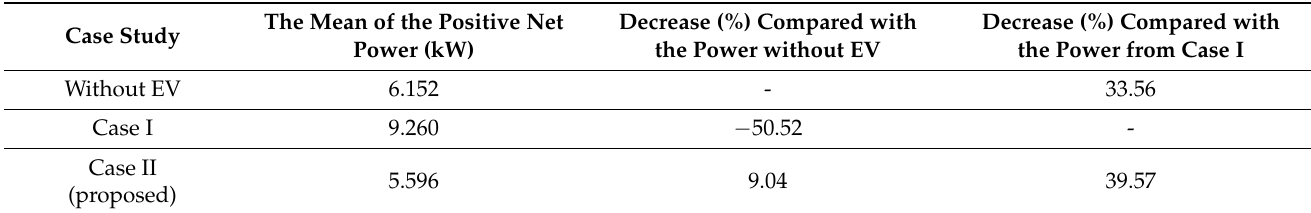
Table 4. The mean of the net power consumption for the without EV case, Case I, and Case